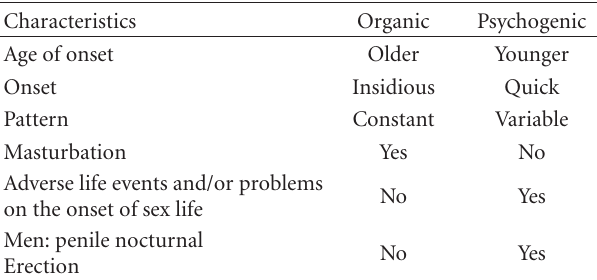
Table 3: Clinical di ff erences between organic and psychogenic sexual